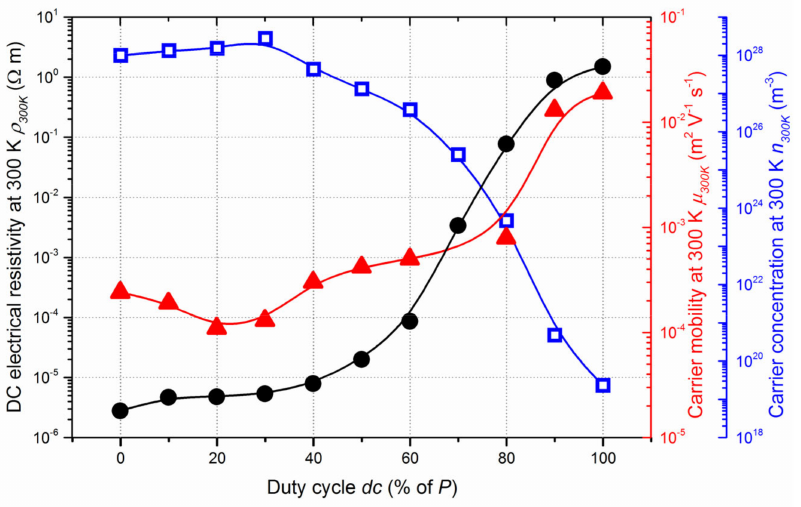
Figure 6. DC electrical resistivity ( ρ 300K ), carrier mobility ( µ 300K ) and carrier concentration ( n 300K ) measured at room temperature as a function of the duty cycle ( dc ) of Ti-B-N thin